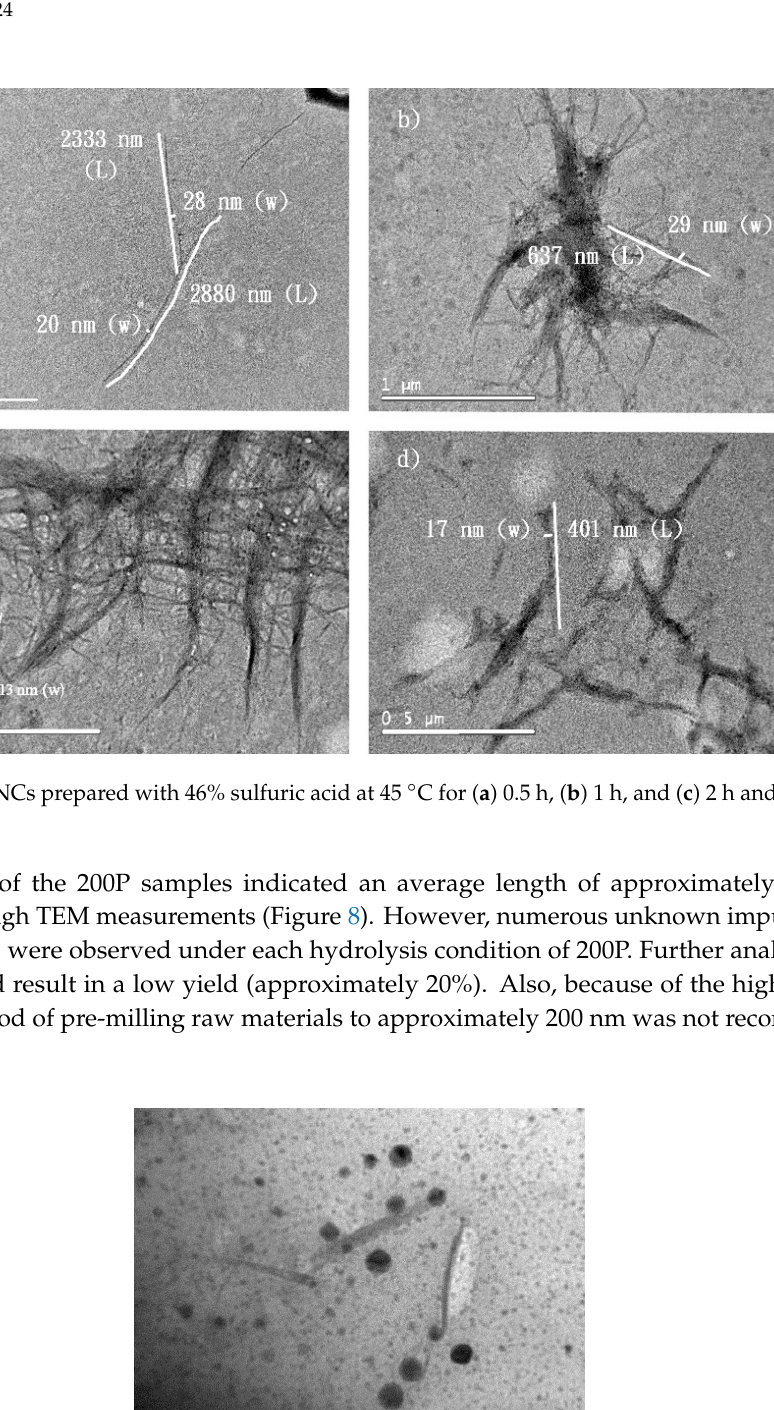
Figure 8. TEM observation of sample “200P”.